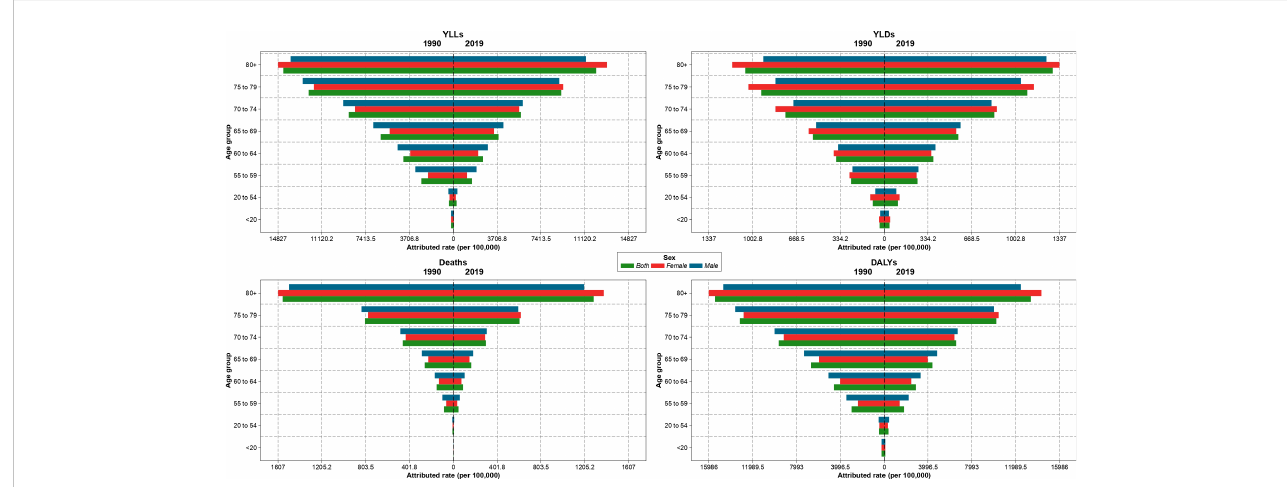
FIGURE 2 Age-standardized rate of years of life lost (YLLs), years lived with disability (YLDs), deaths, and disability-adjusted life years (DALYs) attributable to kidney dysfunction in Iran in 1990 and 2019 by sex and age.